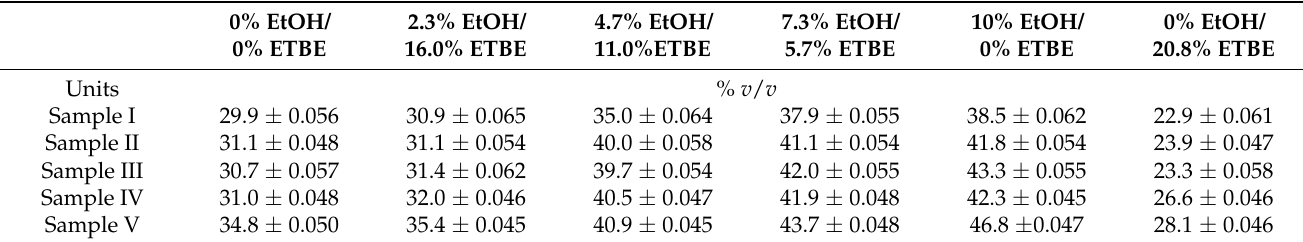
Table 9. E100 of base fuels and bio-EtOH/bio-ETBE blends.